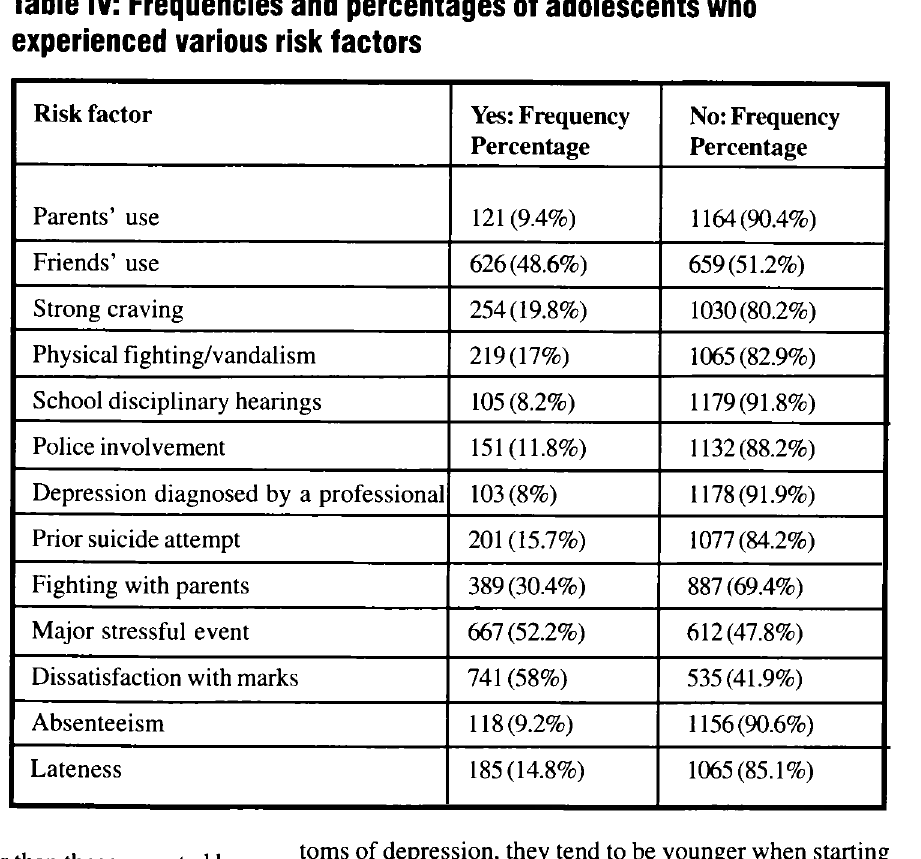
Table IV: Frequencies and percentages of adolescents